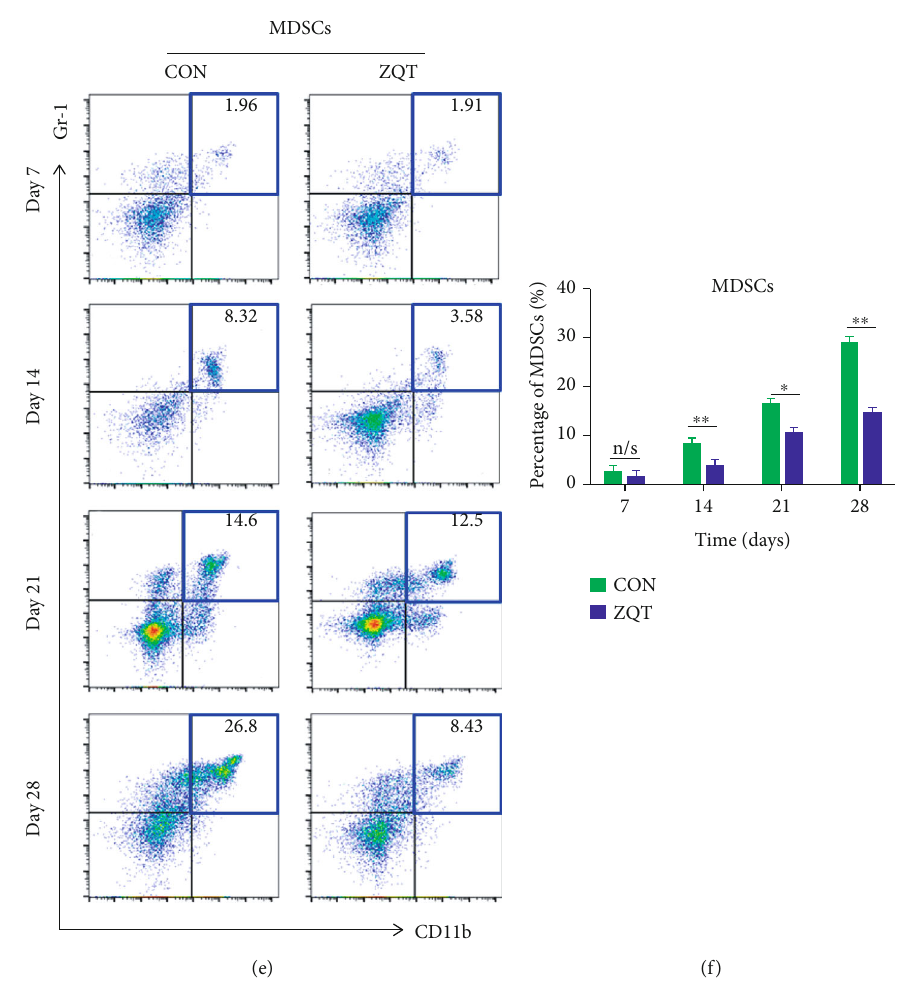
Figure 3: ZQT reduced the population of MDSCs but increased the population of CD8 + T cells in tumor tissue. Cells from the tumor tissue of tumor-bearing mice treated with normal saline or ZQT were analyzed by fl ow cytometry after staining with CD11b, Gr-1, Ly6G, Ly6C, CD3, CD4, and CD8 antibodies. (a – d) Percentages of MDSCs and T cells in tumor. (e, f) Percentages of MDSCs in tumor on days 7, 14, 21, and 28 after inoculation. n = 7 . Data are expressed as the mean ± SD . n/s: nonstatistical signi fi cance. ∗ p < 0 : 05 ; ∗∗ p < 0 : 01 ; ∗∗∗ p < 0 : 001